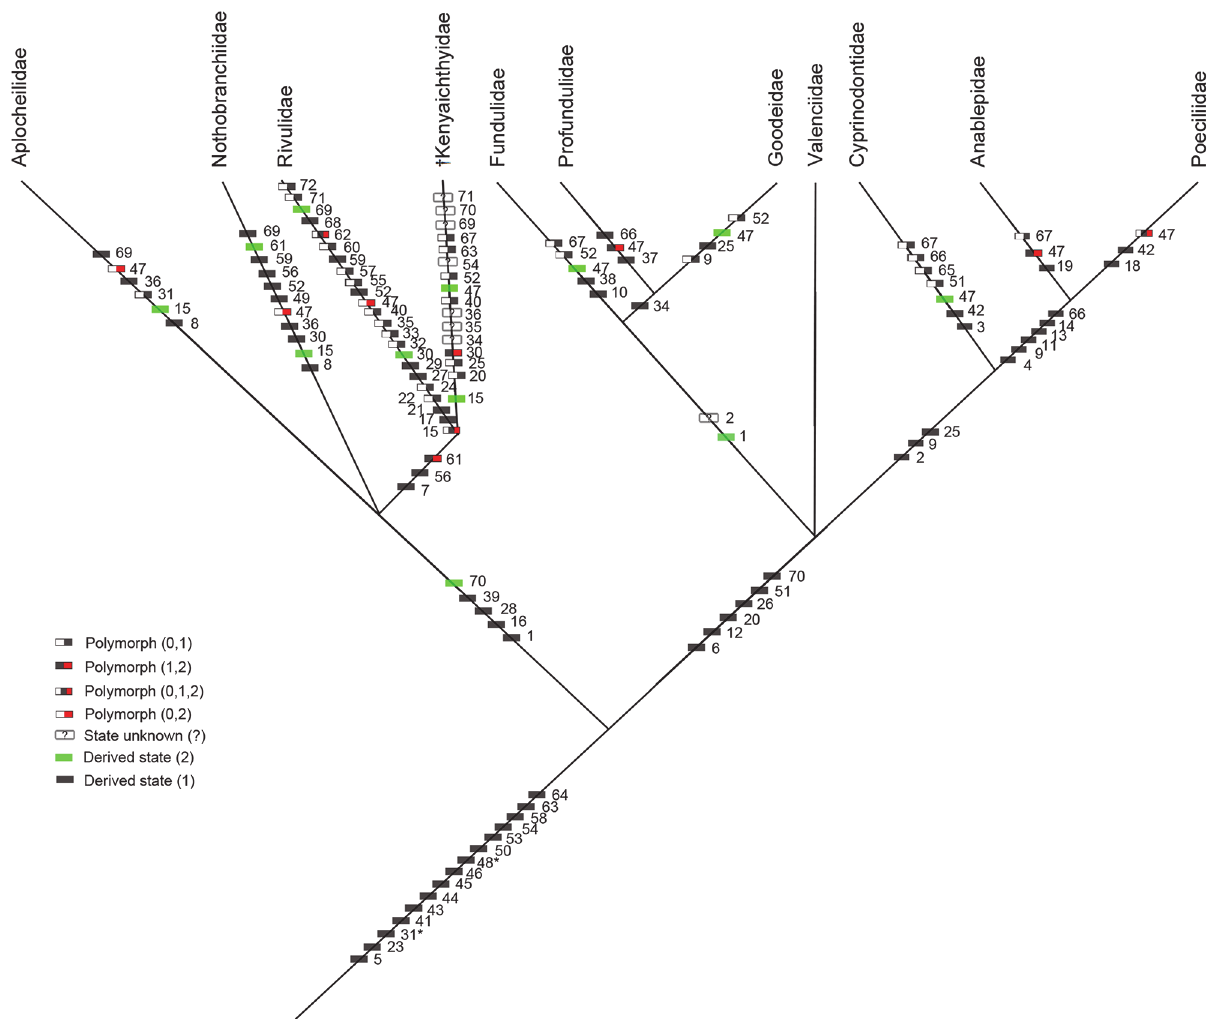
Fig 15. 50% majority-rule consensus tree for the Cyprinodontiformes and † Kenyaichthys gen. et sp. nov. with all the 72 morphological characters mapped. * Indicates character reversals: * character: 31 synapomorphy for all Cyprinodontiformes, but reversal in some Poeciliidae and Aplocheilus ; * character 48: synapomorphy for all Cyprinodontiformes with reversal in some Nothobranchiidae and